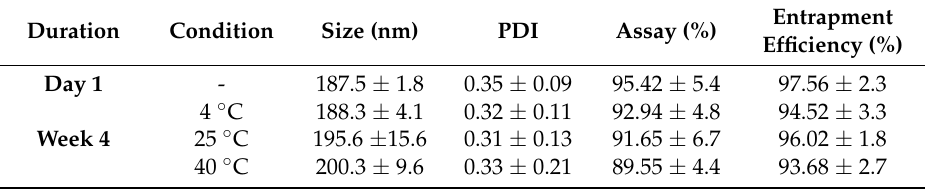
Table 4. Stability studies of optimized TA-SLN formulation (F5) at different temperatures for one month (mean ± SD, n = 3).